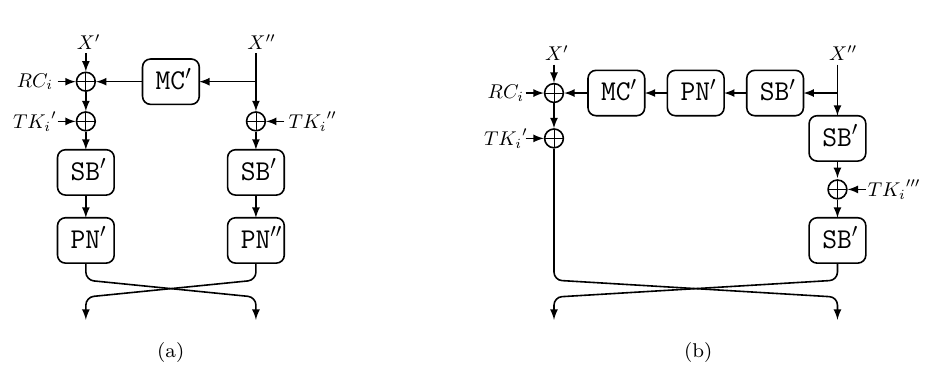
Figure 2: The round function for (a) CRAFT representation, and (b) equivalent CRAFT . Property 2. PN operation replaces the left half of the state with a nibble permutation of the right half and vice versa,